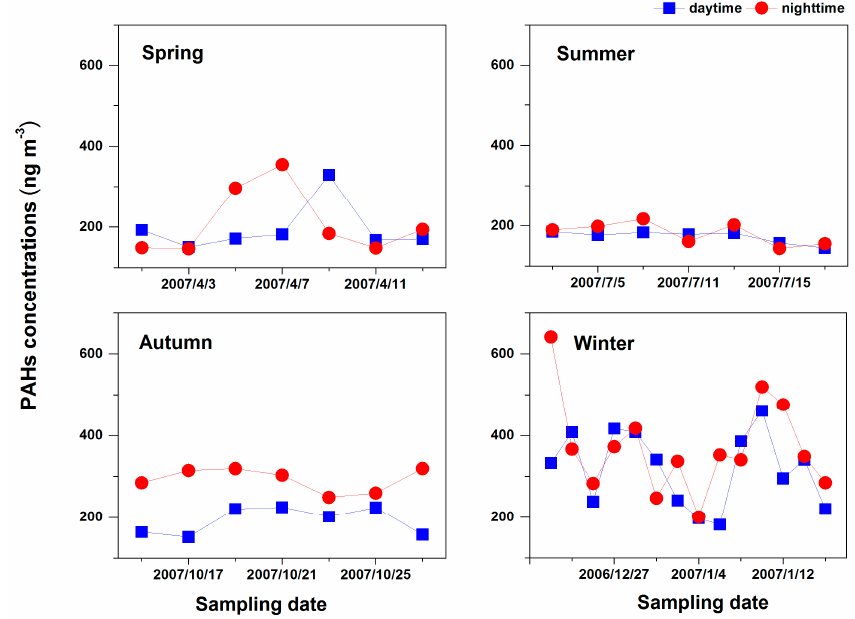
Figure 2. Day–night variations of PAHs in each season.